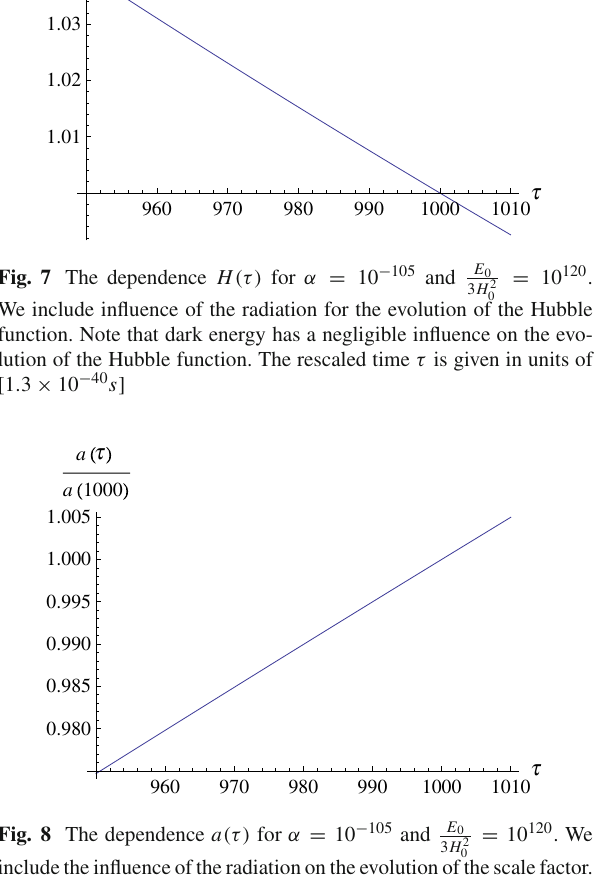
Fig. 8 The dependence a (τ) for α = 10 − 105 and E 0 include the influence of the radiation on the evolution of the scale factor. Note that dark energy has negligible influence on the evolution of the scale factor. The rescaled time τ is given in units of [ 1 . 3 × 10 − 40 s ]